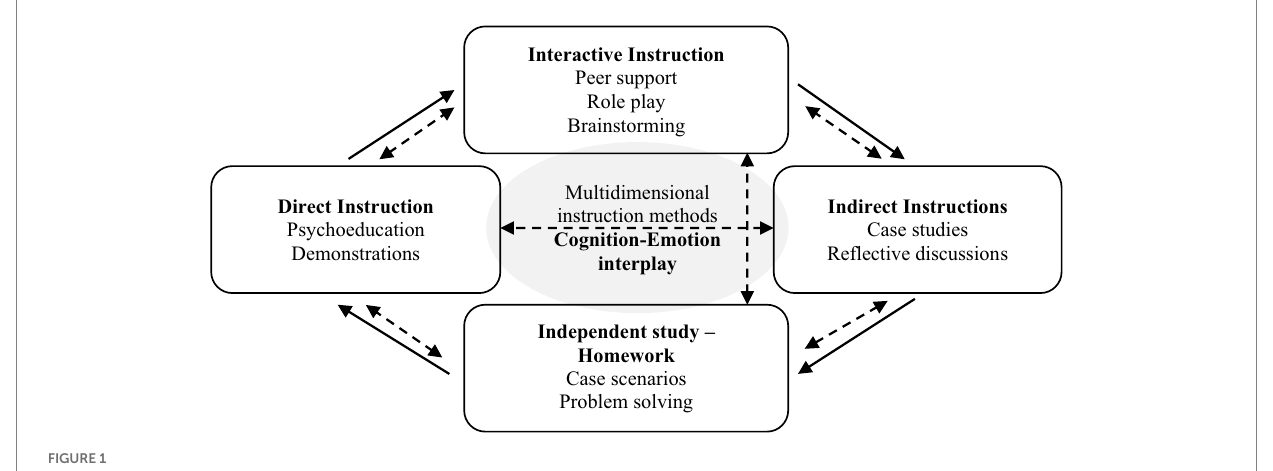
FIGURE 1 Multidimensional instruction methods.